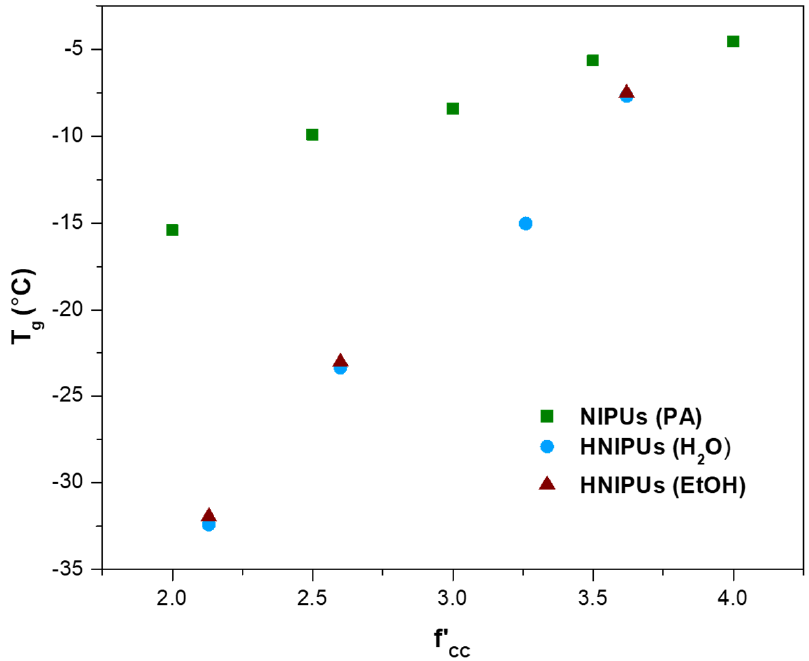
Figure 13. Glass transition temperature (T g ) comparative values for NIPU-HNIPUs.